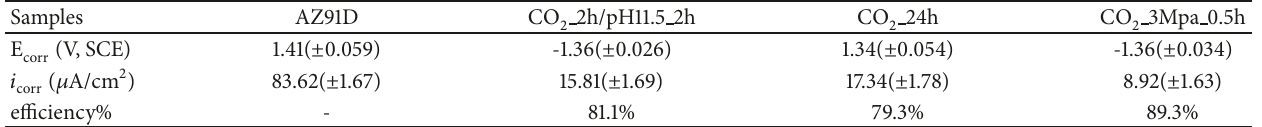
Table 3: Electrochemical test results of the AZ91D alloy with and without LDH conversion coating.